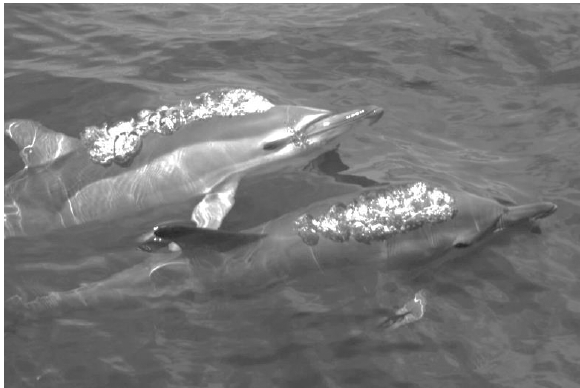
Figure 6. Common dolphins during survey in Ionian Sea. (Photo by Ketos association).